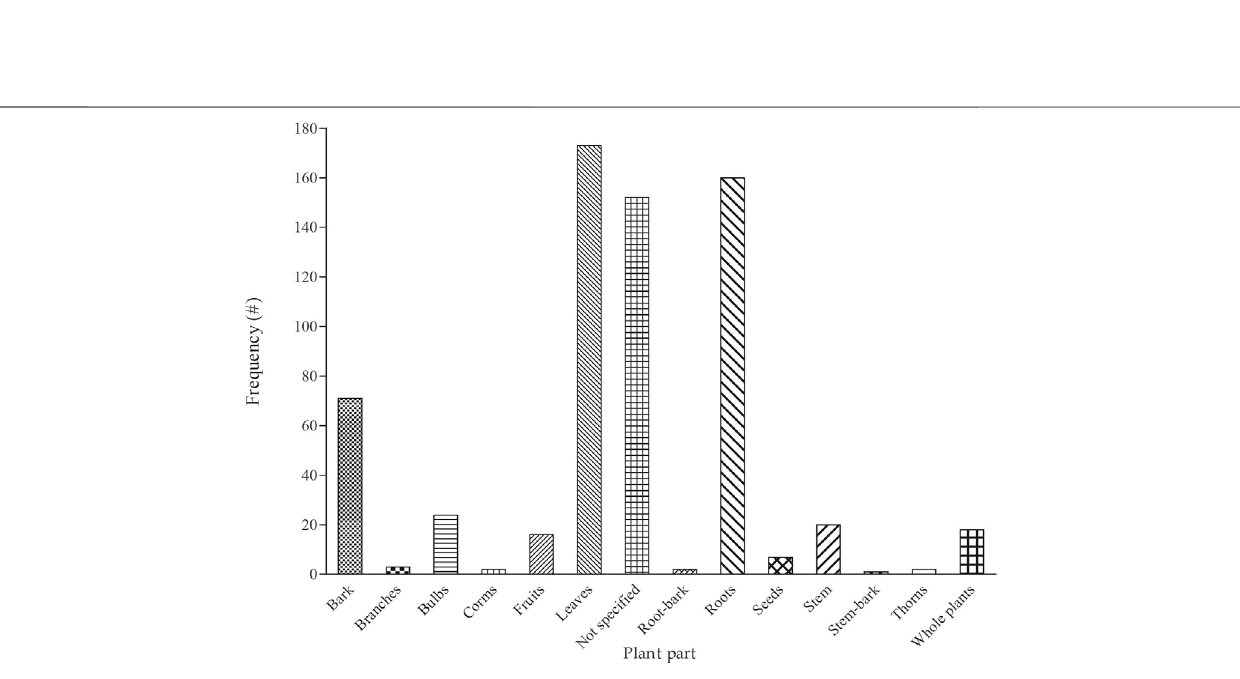
Frontiers in Pharmacology |